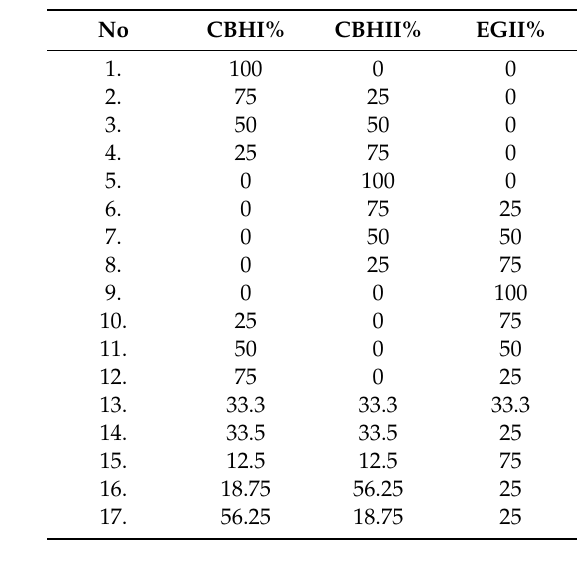
Table 3. Enzyme combinations (%) at a total protein dosage of 1.875 mg / g biomass for paper sludge hydrolysis synergy studies with BGL added subsequently at 10% of the total protein